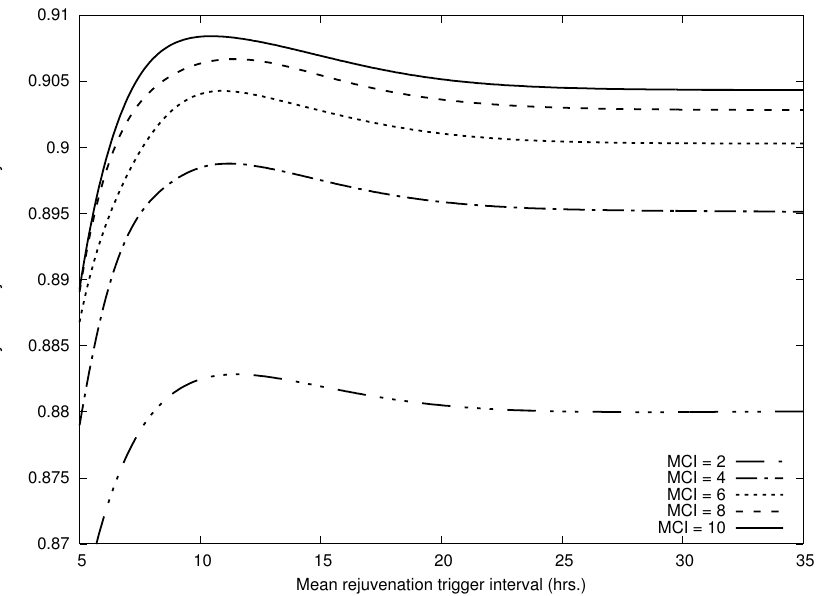
Figure 5. Sensitivity of steady-state system availability with respect to mean rejuvenation-trigger